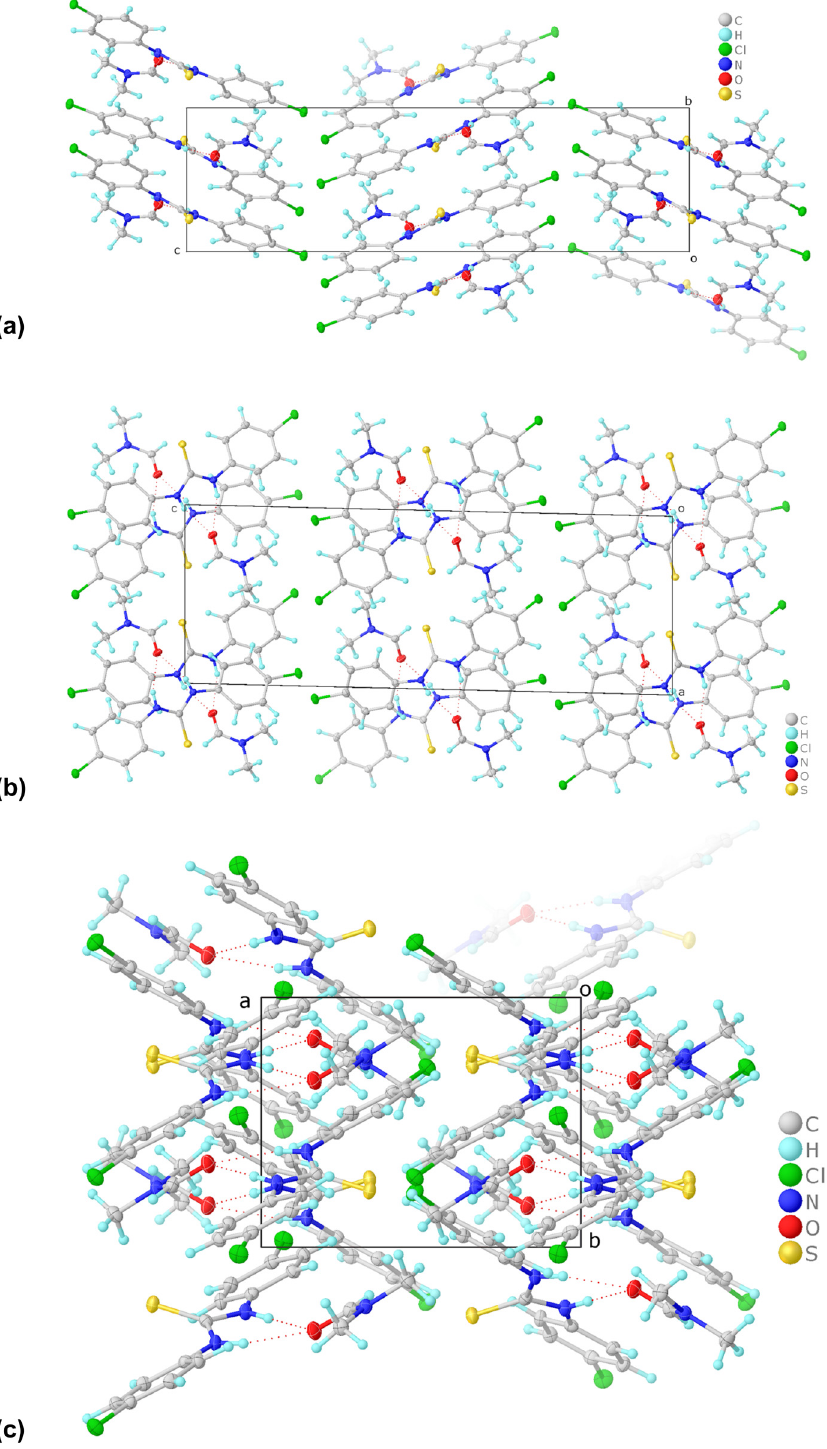
Figure 2: ( a ) Crystalline structure of C 16 H 17 Cl 2 N 3 OS along a axis. ( b ) Crystalline structure of C 16 H 17 Cl 2 N 3 OS along b axis. ( c ) Crystalline structure of C 16 H 17 Cl 2 N 3 OS along c